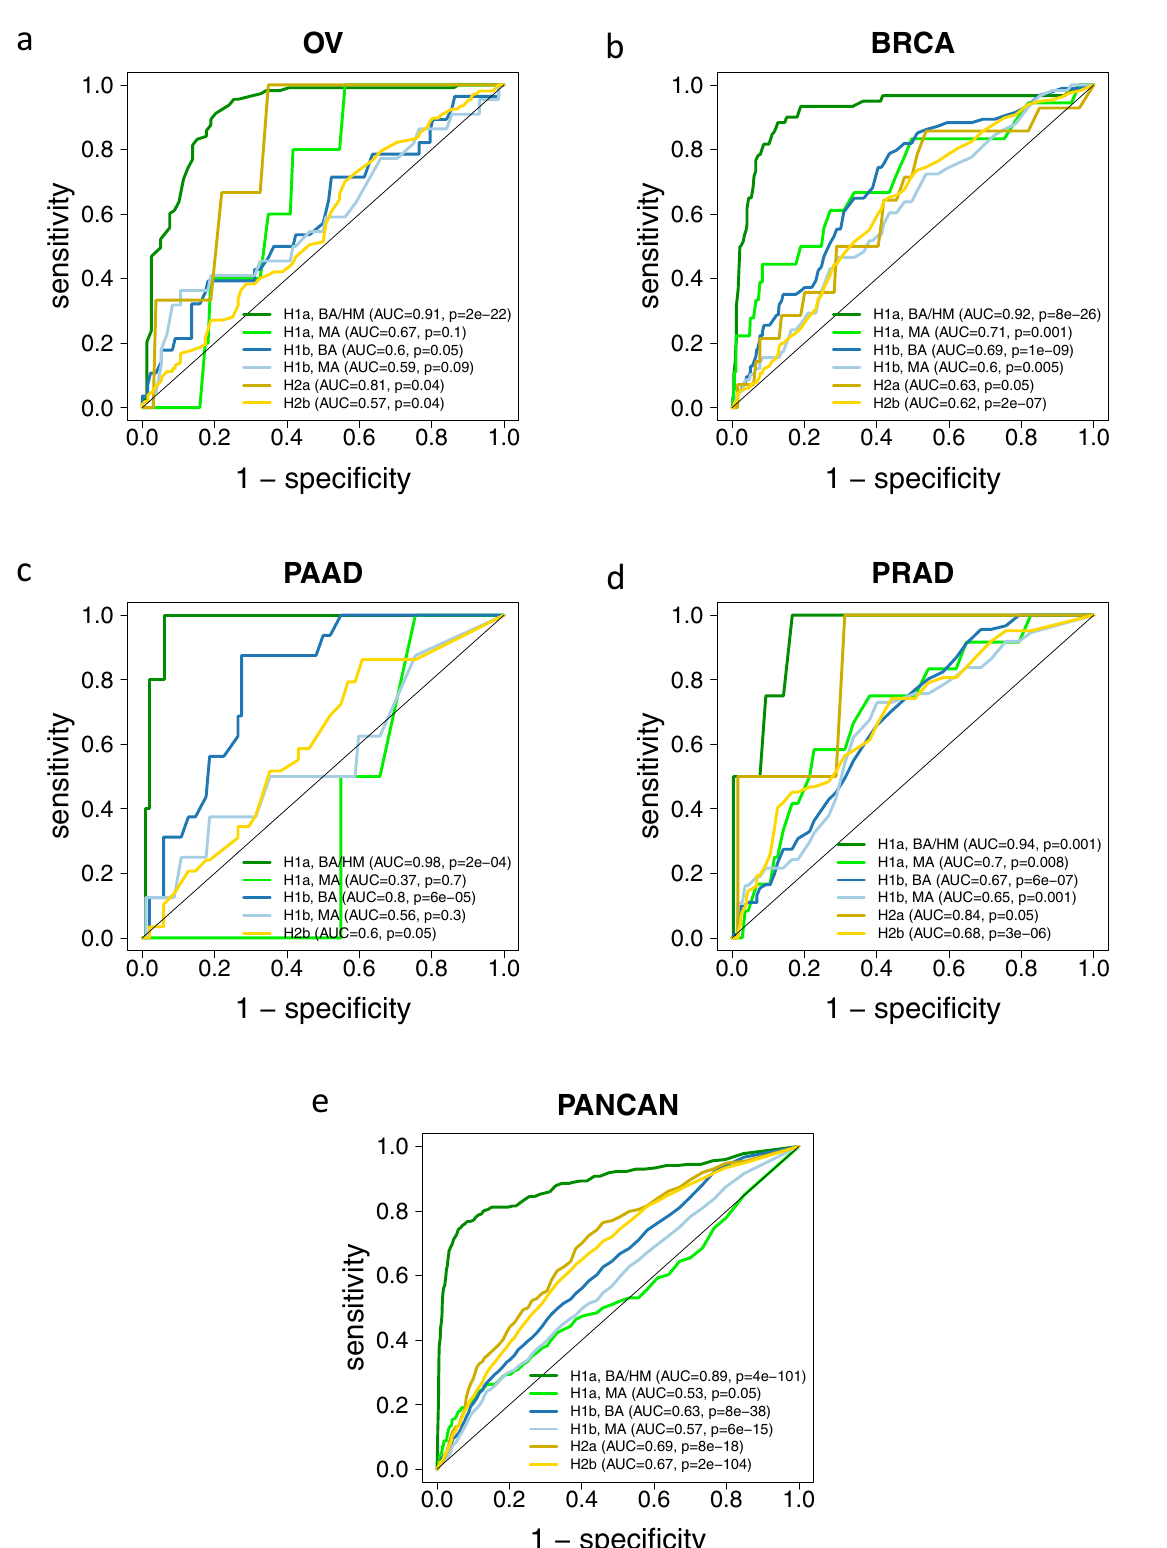
Fig. 5 Separation of tumors with alterations in HRR genes (classes H1a-H2b) from tumors without such alterations (class H3) by HRDsum. Tumors with BRCA1 promotor-hypermethylation (HM) were included in class H1a, BA (biallelic alteration). a Ovarian cancer (OV). b Breast cancer (BRCA). c Pancreatic adenocarcinoma (PAAD). d Prostate adenocarcinoma (PRAD). e Across 33 cancer types